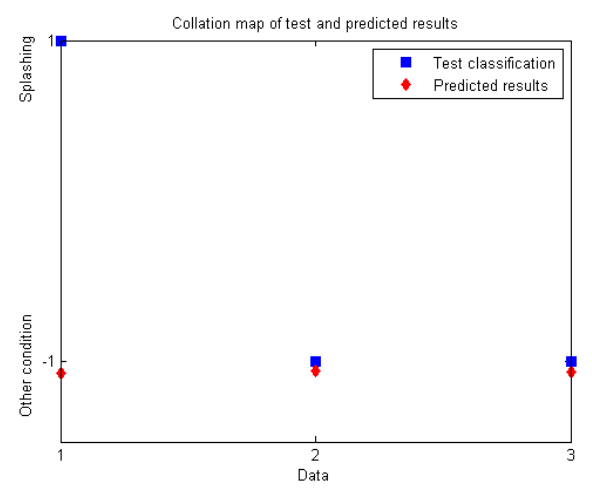
Figure 16. Collation map of test and predicted results. Table 2. The detailed comparison results.